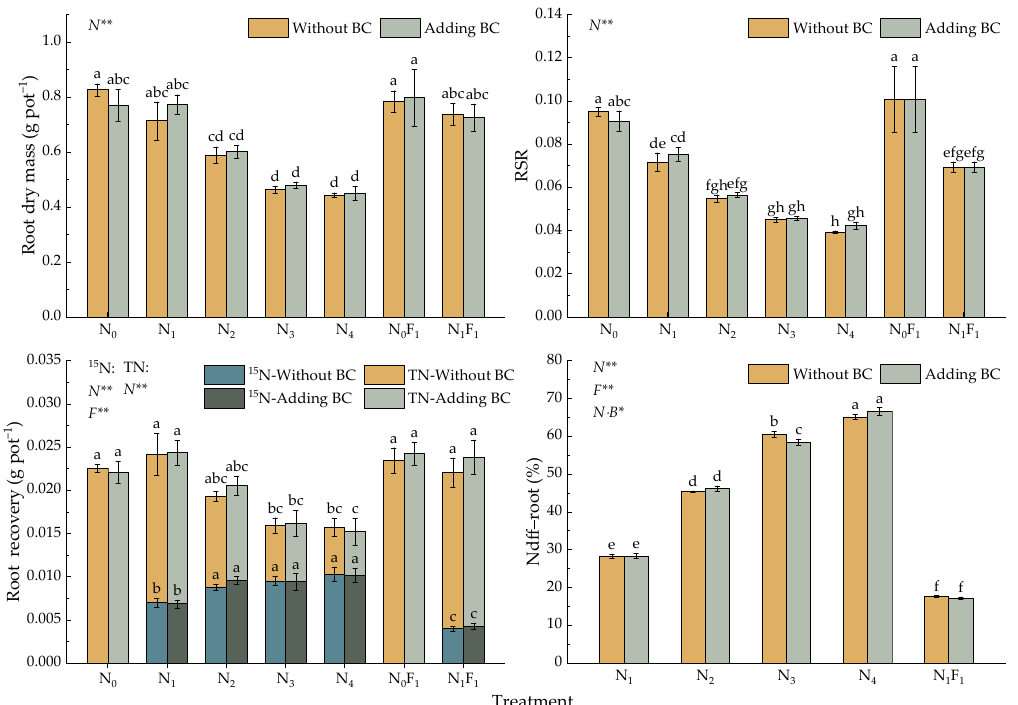
Figure 3. Root dry mass, RSR, 15 N recovery , and its proportion. Note: RSR means root crown ratio. Vertical bars represent standard errors of the means (n = 5). Different letters represent statistical class among the treatments at p < 0.05, and the presence of means with the same letter is not significantly different. Source of variation, N = 15 N-labeled urea; B = brown coal; F = organic manure. * and ** indicate significant differences at p < 0.05 and p < 0.01, respectively. N 0 , N 1 , N 2 , N 3 , and N 4 represent the urea application rate, 0, 100, 200, 300, and 400 kg N ha − 1 , respectively. F 1 represents organic manure of 100 kg N ha − 1 .